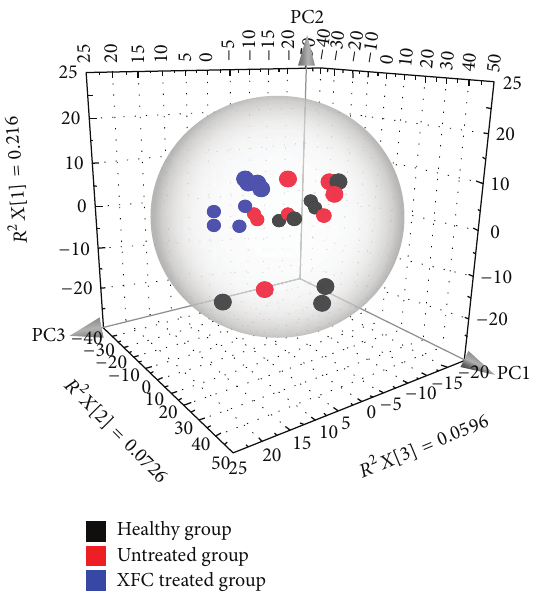
Figure4:PCAscoreplotsofadjuvant-inducedarthritisinratsurine metabolic profiling of healthy group, untreated group, and XFC treated group using GC-TOF/MS.